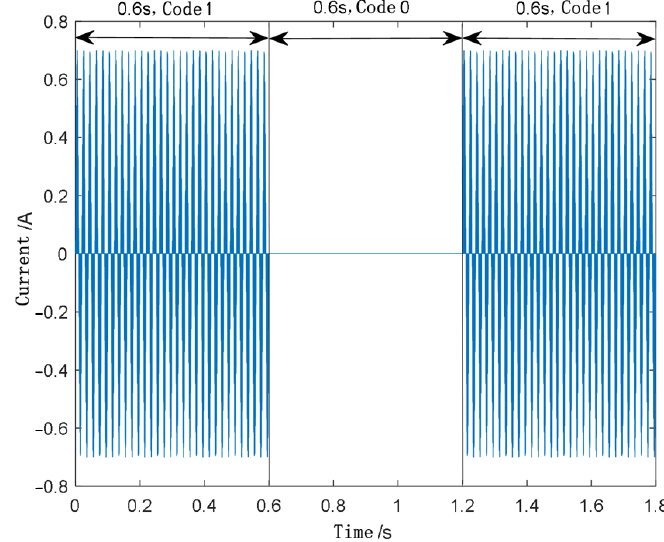
Figure 6. Schematic diagram of OOK modulation realization.